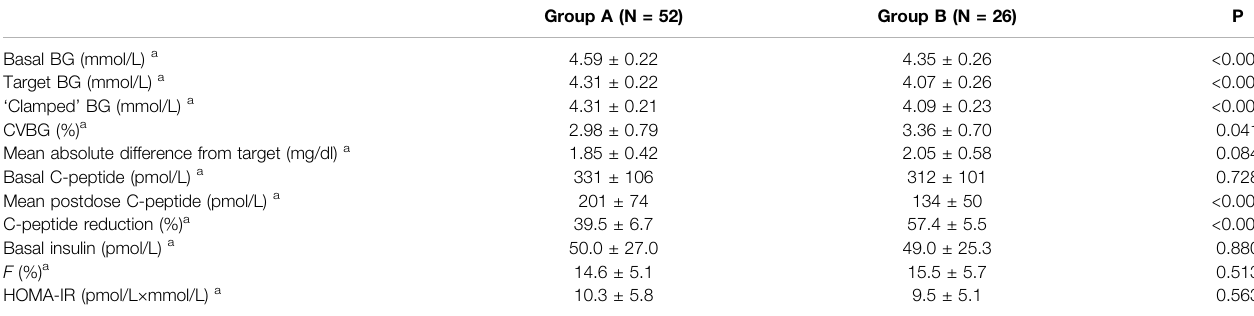
TABLE 2 | Euglycemic Clamp Statistics and C-peptide levels.